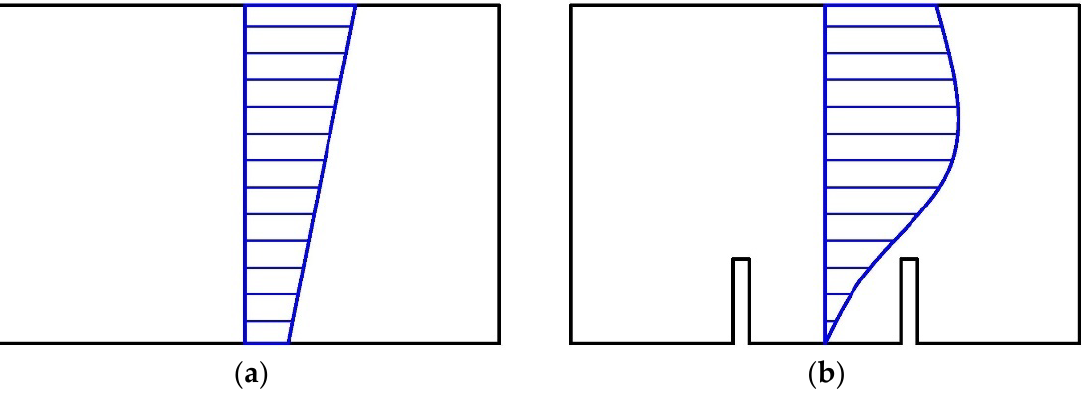
Figure 1. Normal stress distribution in PC member—before sawing ( a ); after sawing ( b ).